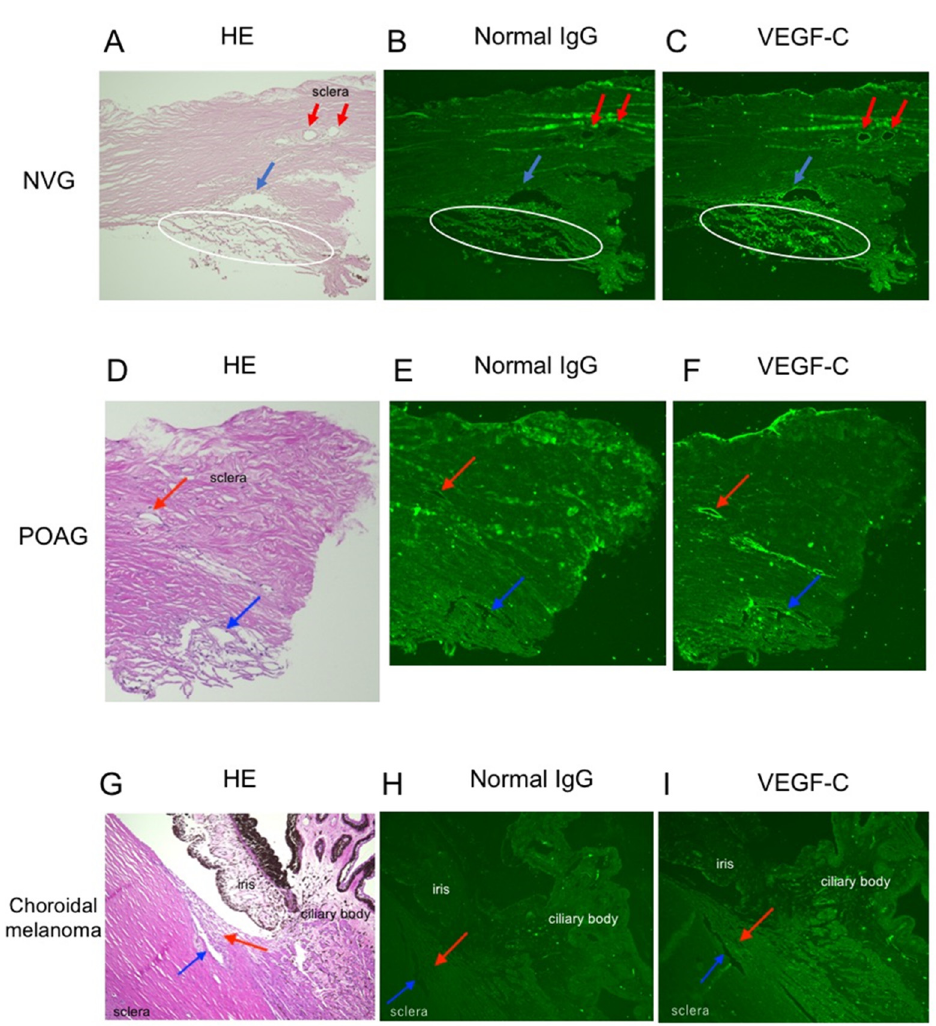
Figure 1. Localization of vascular endothelial growth factor (VEGF)-C in the angle tissues of patients with neovascular glaucoma, primary open-angle glaucoma and non-glaucoma. ( A – C ) The angle tis- sue of a 68-year-old man with neovascular glaucoma secondary to proliferative diabetic retinopa- thy. ( A ) HE staining. ( B ) Negative control with normal IgG antibody for immunohistochemistry. ( C ) Immunohistochemistry for VEGF-C. Immunoreactivity for VEGF-C proteins was found in the trabecular meshwork, Schlemm’s canal endothelial cells and collecting ducts. White circle indicates the trabecular meshwork. Blue arrow indicates Schlemm’s canal. Red arrow indicates the collecting duct. ( D – F ) The angle tissue of a 58-year-old man with primary open-angle glaucoma. ( D ) HE stain- ing. ( E ) Negative control with normal IgG antibody for immunohistochemistry. ( F ) Immunohisto- chemistry for VEGF-C. Blue arrow indicates Schlemm’s canal. Red arrow indicates the collecting duct. ( G – I ) The angle tissue of a 72-year-old man with choroidal malignant melanoma as a control. ( G ) HE staining. ( H ) Negative control with normal IgG antibody for immunohistochemistry. ( I ) Im- munohistochemistry for VEGF-C. Blue arrow indicates Schlemm’s canal. Red arrow indicates the trabecular meshwork. A white circle indicates the trabecular meshwork. A blue and a red arrow ( A – F ) indicates Schlemm’s canal and the collecting duct, respectively. A red arrow ( G – I ) indicates the trabecular meshwork.